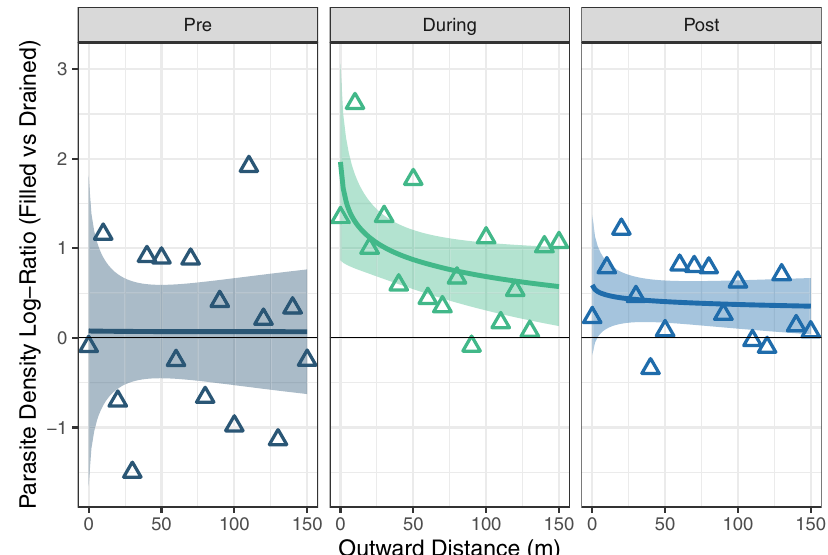
Fig. 3 Log ratio of parasite density from dung at fi lled water pans relative to experimentally drained water pans throughout the experiment (pre- draining, during experiment, and post-re fi lling). Points and lines that lie above 0 indicate increased density at fi lled pans relative to experimental pans. Points show parasite density log-ratios at each 10 m outward distance interval and experimental status (averaged over site and period); colors show each experimental phase. Lines represent best linear fi ts (±SE) to the points (using log(Distance)). Species-speci fi c fi gures illustrating zero-in fl ated data are available in Supplementary Appendix Fig. S7. Source data are provided as a Source Data fi le.